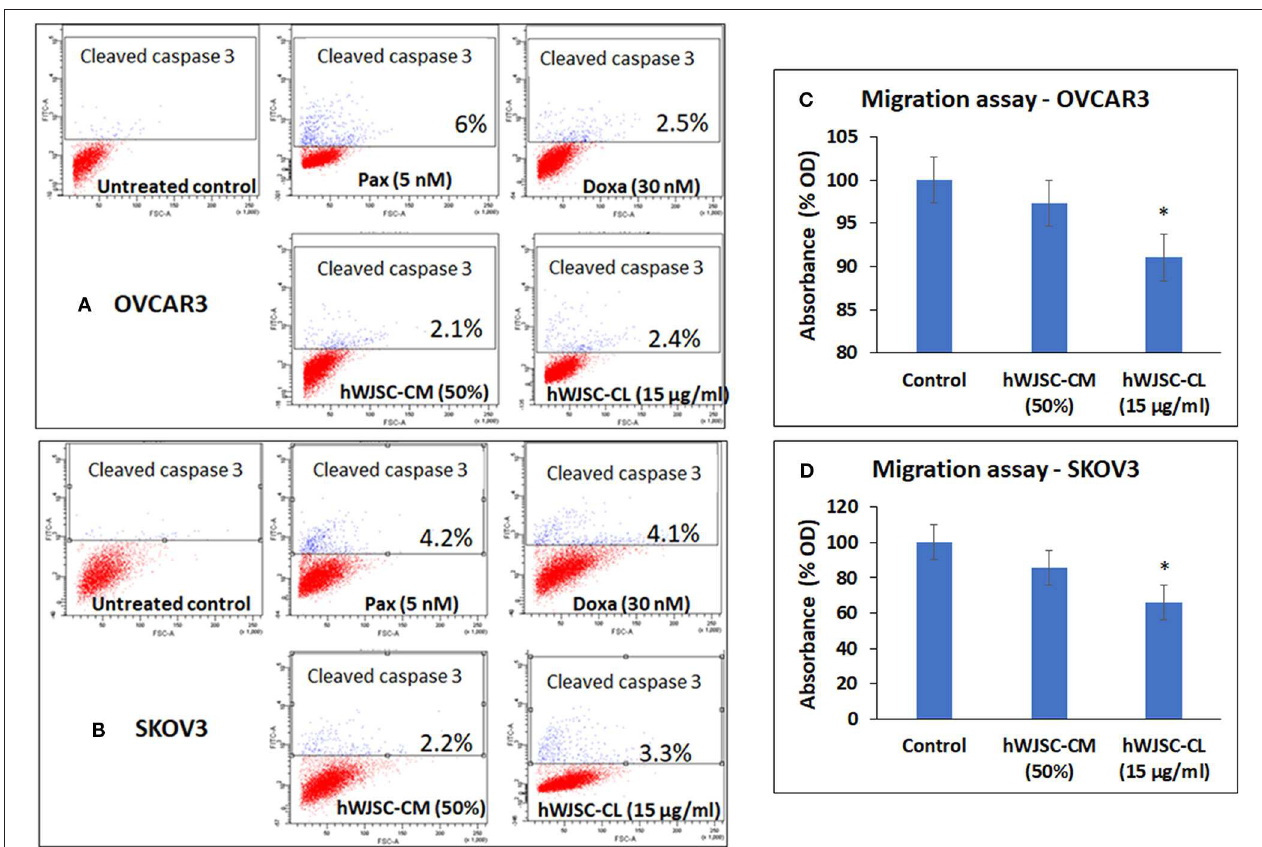
FIGURE 7 | Representative scatter plots of Caspase 3 assay in (A) OVCAR3 and (B) SKOV3 cells follwing treatment with hWJSC-CM (50%),hWJSC-CL (15 µ g/ml), paclitaxel (5nM) and doxorubicin (30nM) for 24h. Mild expression of activated caspase 3 activity was observed in the treated group compared to the control following staining with FITC conjugated rabbit anti-caspase 3 antibody. Cell migration of (C) OVCAR3 and (D) SKOV3 following treatment with hWJSC-CM (50%) and hWJSC-CL (15 µ g/ml) for 48h. Decrease in cell migration was observed only with and hWJSC-CL (15 µ g/ml) in both OVCAR3 and SKOV3 cells. The values are expressed as mean ± SEM of three different experiments. *indicates statistical significance ( p <